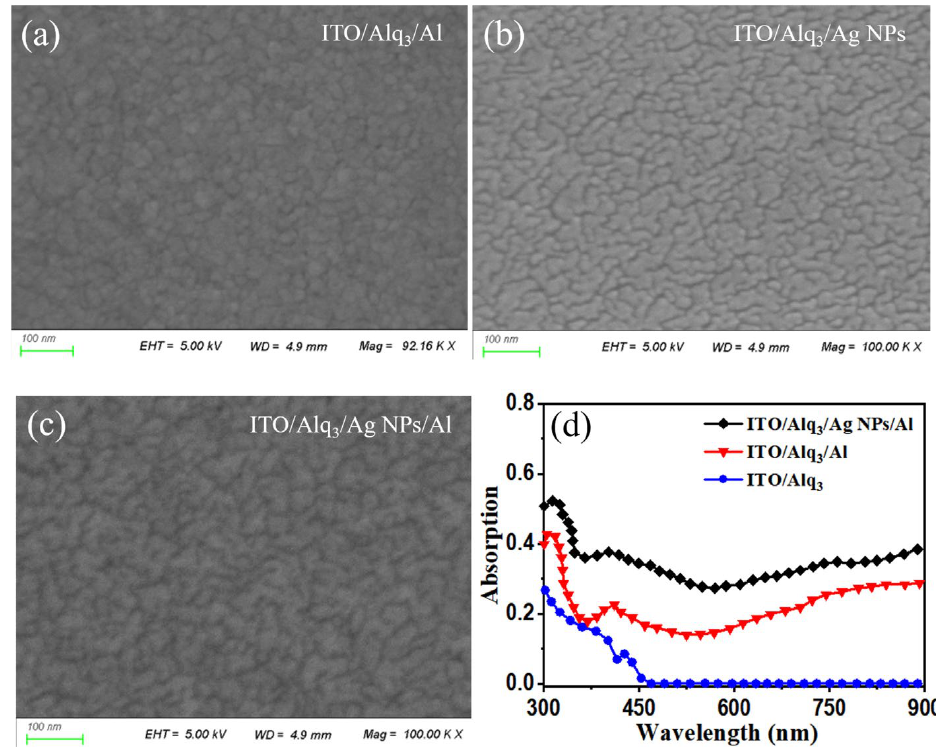
Figure 3. ( a – c ) SEM images of top surfaces of the ITO/Alq 3 film, the ITO/Alq 3 /AgNP film, and the ITO/Alq 3 /AgNP/Al OPD. ( d ) Measured absorption spectra of the ITO/Alq 3 structure, the control OPD (ITO/Alq 3 /Al), and the plasmonic OPD (ITO/Alq 3 /AgNP/Al).